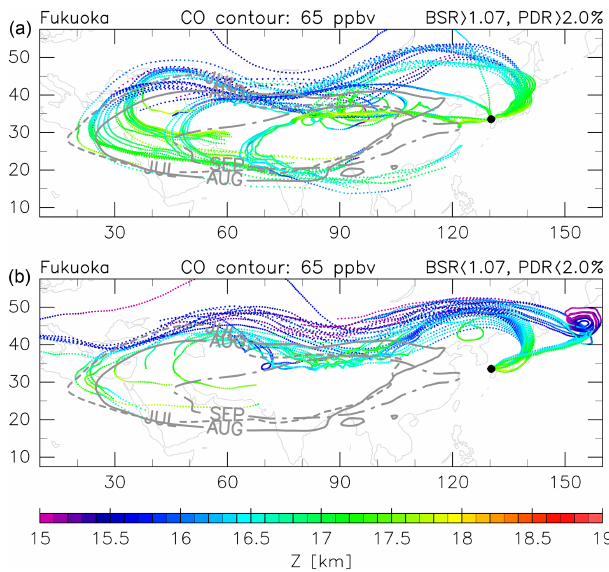
Figure 4. Kinematic backward trajectories for 10d starting from Tsukuba in the 390–410K potential temperature range at 100m geopotential height intervals on all days during July– September 2018 on which measurements were made using ERA5 reanalysis data. Cases are sorted into two categories: (a) with and (b) without enhanced aerosol signals observed by lidar at the tra- jectory starting points. The conditions and number of trajectories for the former and the latter cases are respectively BSR > 1.07 and PDR > 2.0% with 78 trajectories and BSR < 1.07 and PDR < 2.0% with 136 trajectories. Colours indicate geopotential height ( Z ) val- ues of the trajectories. Grey contours indicate 65ppbv monthly mean CAMS CO levels at 400K potential temperature, roughly in- dicating monthly mean boundaries of the ASM anticyclone (dotted for July, solid for August, and dash-dotted for September).